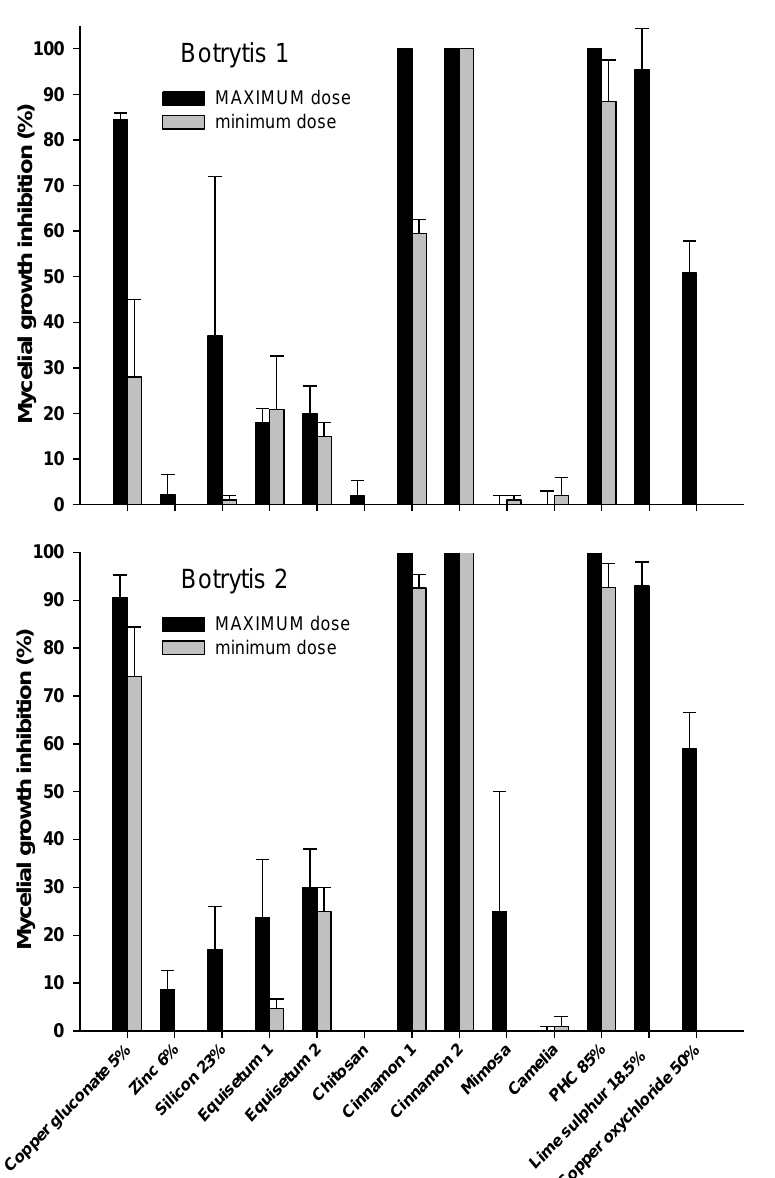
Figure 3. Mean inhibition (%) of mycelial growth and standard deviation of the mean for Botrytis 1 and Botrytis 2 isolates of B. cinerea grown on PDA amended with 12 selected products (three mineral fertilisers with low or no copper content: copper gluconate 5%, zinc 6%, and silicon 23%; three formulations based on basic substances: two formulations of Equisetum and chitosan; four formulations based on plant extracts: two formulations of cinnamon, mimosa, and camelia; two fungicides authorised for organic farming: potassium hydrogen carbonate 85% and lime sulphur 18.5%) at two doses (minimum and maximum doses recommended by the distributor).